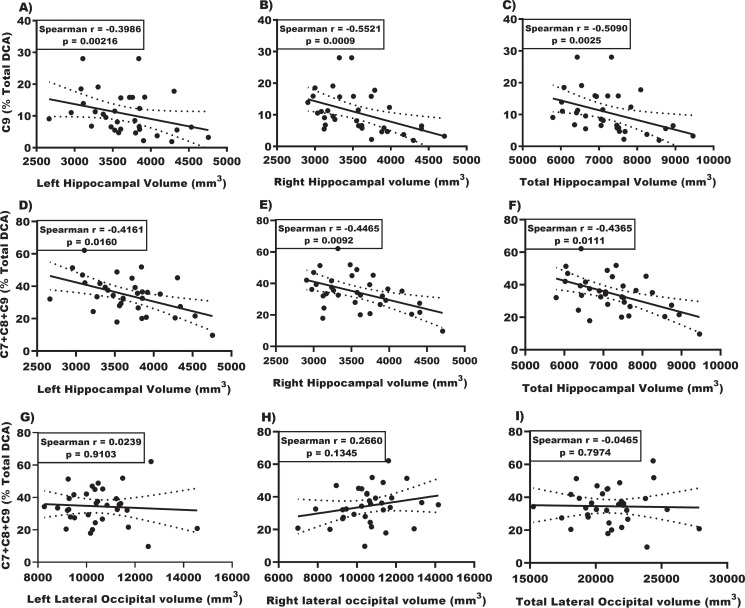
Correlation of urine DCA levels with brain volumes.Top graphs. Correlations of C9 levels in urine with left (A), right (B), and total hippocampal (C) volume for CH individuals. Middle graphs: Correlations of the sum of DCAs (C7+C8+C9) that increase in urine with left (D), right (E), and total hippocampal volumes for CH individuals (F). Bottom graphs: Correlations of the sum of DCAs (C7+C8+C9) that increase in urine with left (G), right (H), and total lateral occipital volumes (I) for CH individuals.